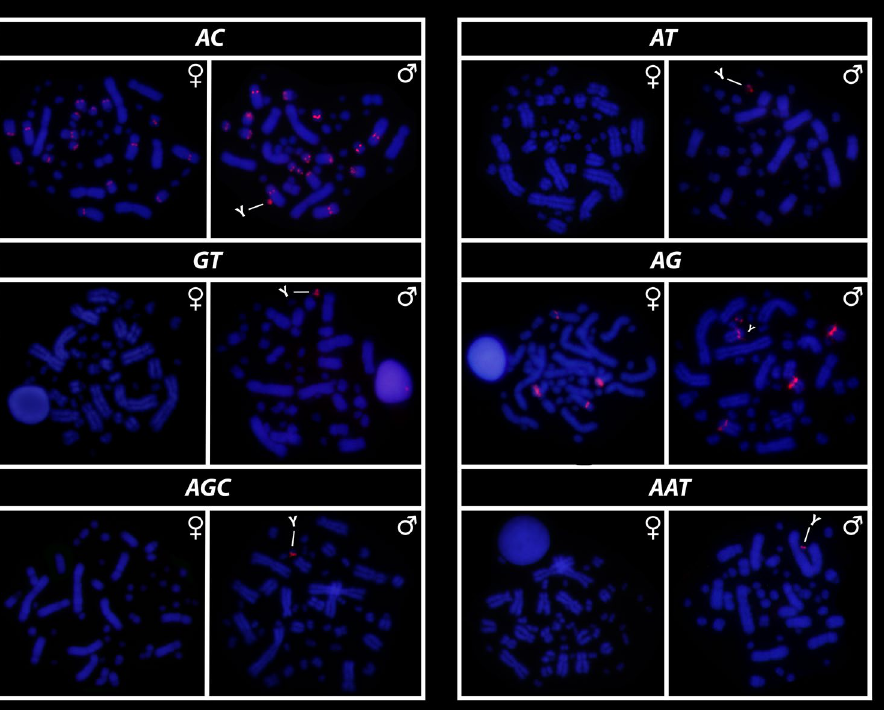
Figure 5. Mapping of several SSR repeats on the chromosomes of male and female of Chelus orinocensis , with highlights to an association of AG motif with the 9th pair that harbors the rDNA sites and the particular accumulation on the mic Y lines).